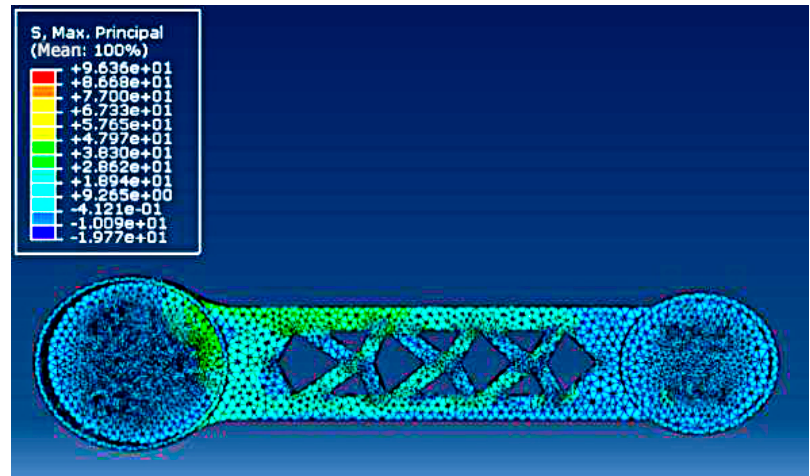
Figure 24. Maximum tensile stress distribution in the most unfavorable working condition.